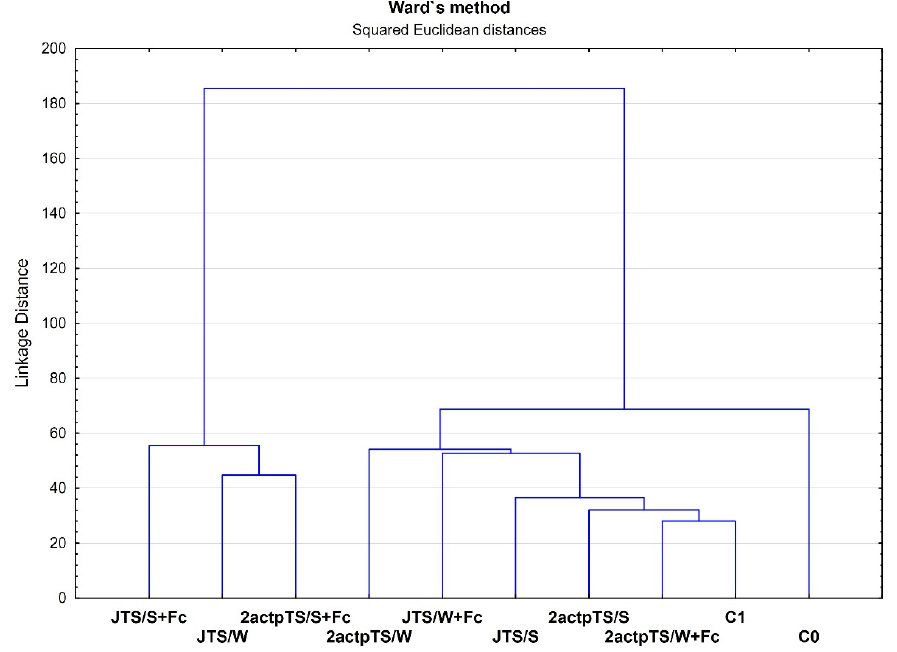
Figure 4. Hierarchical dendrogram of samples using Ward’s clustering method with bond dis- tances. Boundaries of Sneath’s criteria, restrictive (33%) and less restrictive (66%), are marked on the dendrogram.